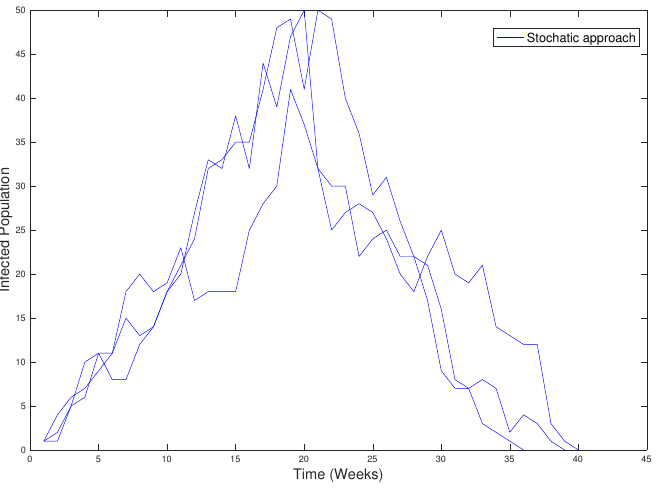
Figure 25. Simulations on graph obtained in Figure 24.